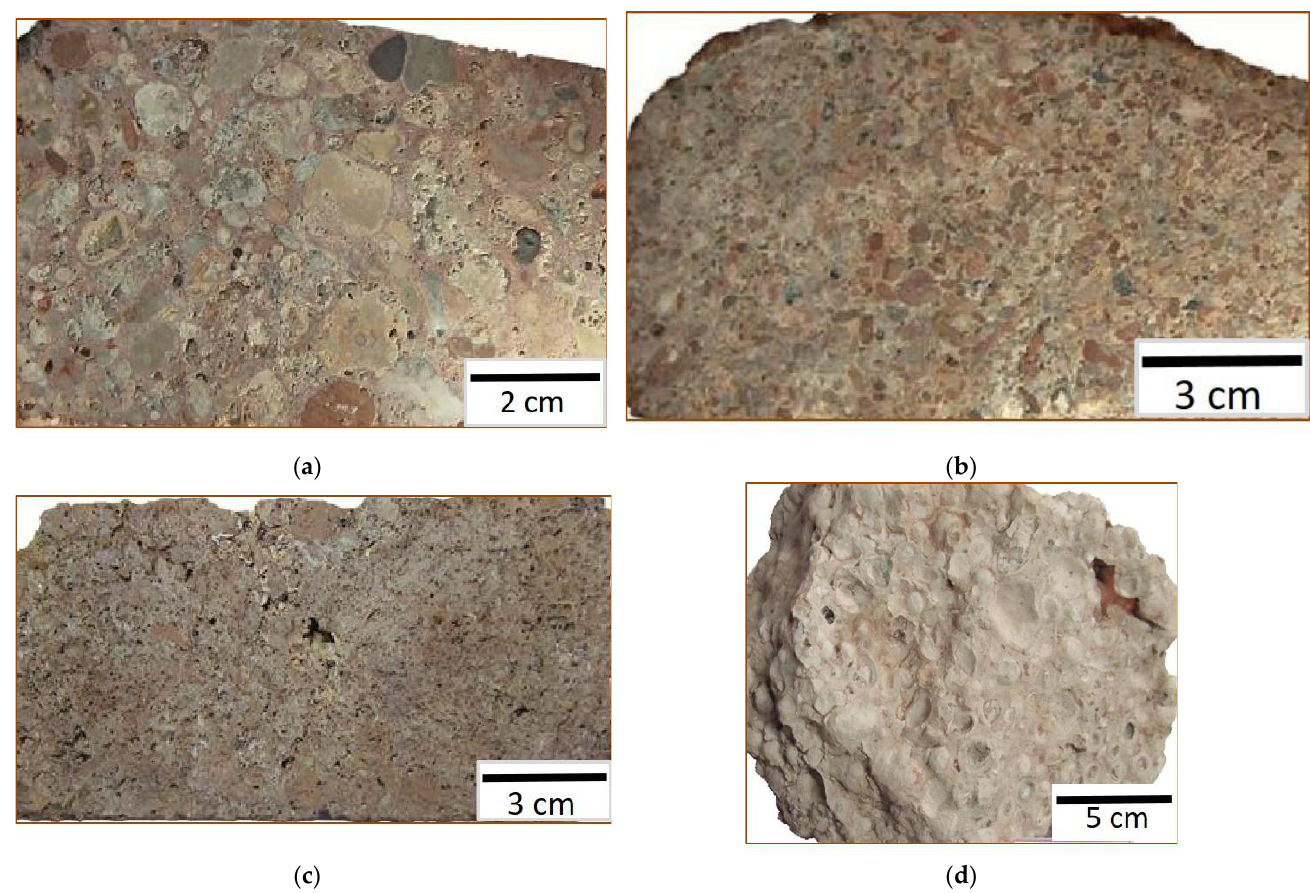
Figure 6. Photos sedimentary-lateritic bauxites: ( a ) conglomerate bauxites, ( b ) gravelstone bauxites, ( c ) sandstone-like bauxites, and ( d ) oolitic bauxites. Table 1. The average chemical composition of bauxites of the Sangaredi District of various litholog- ical types with consideration of their depth of occurrence.